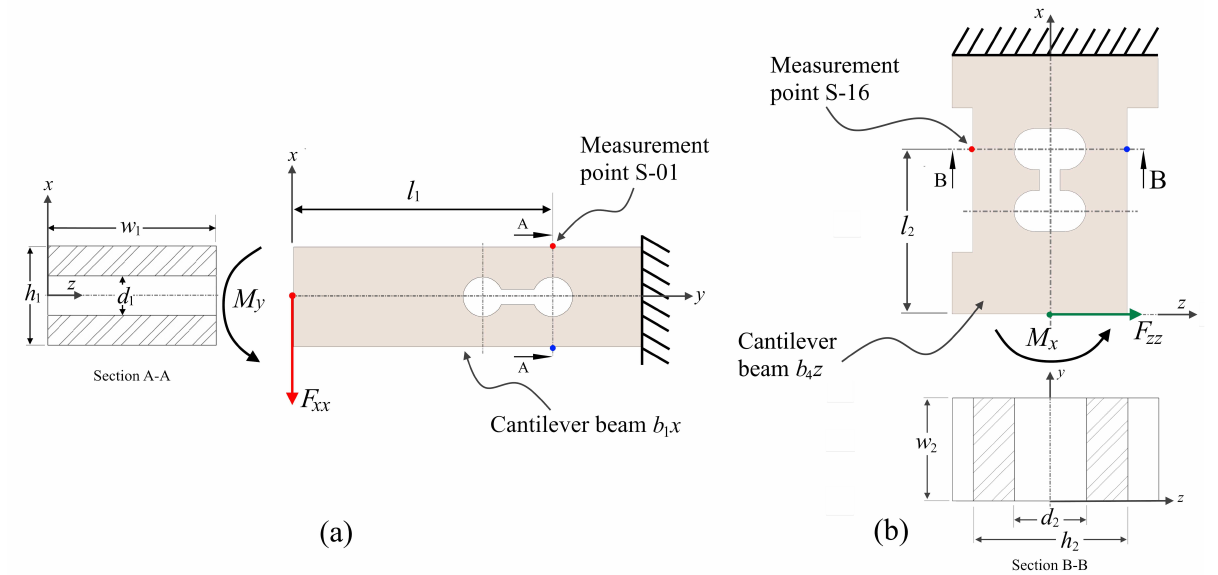
Figure 4. Cantilever beam model in cross-beam force transducer: ( a ) force in x -direction; ( b ) force in z